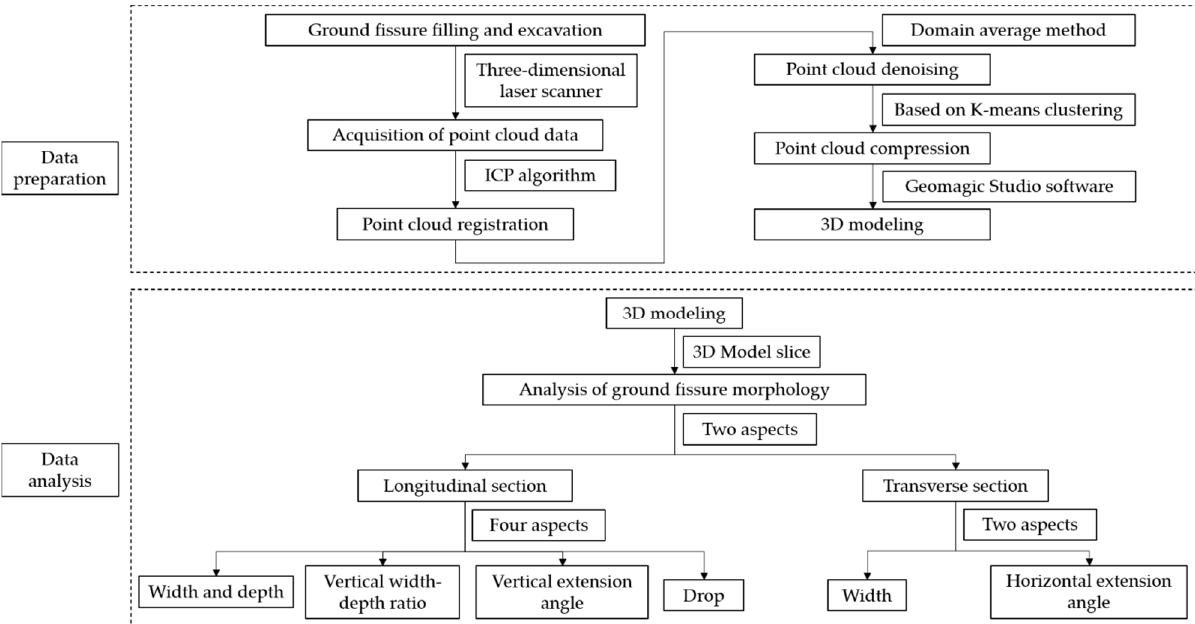
Figure 1. The data flow chart.